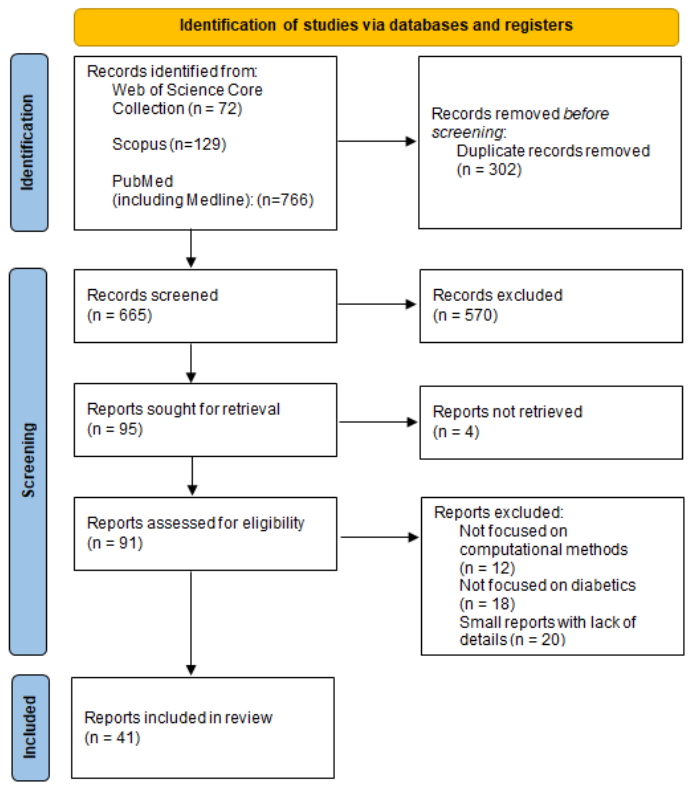
Figure 3. Systematic flow diagram representing the inclusion of studies according to the PRISMA 2020